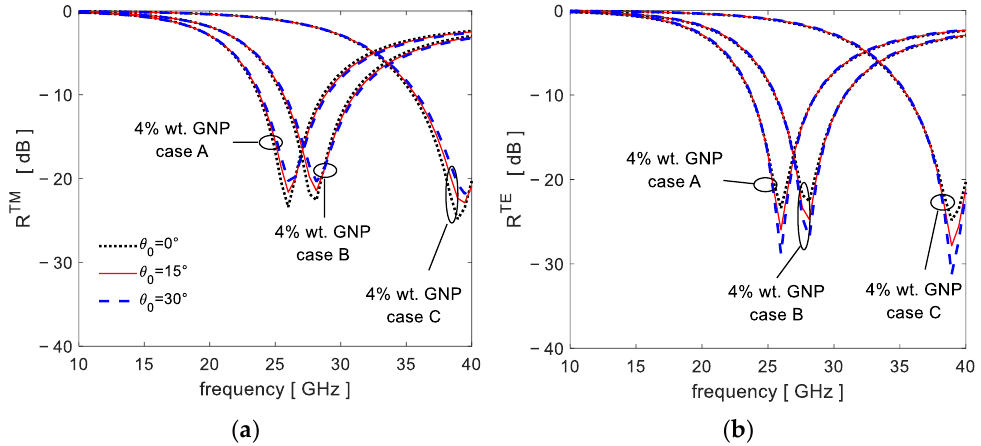
Figure 12. Reflection coefficients ( a ) R TM and ( b ) R TE as functions of the incidence angle for the cases A, B and C shown in Table 3 and composite filled with 4% of GNPs. A, B and C shown in Table 3 and composite filled with 4% of